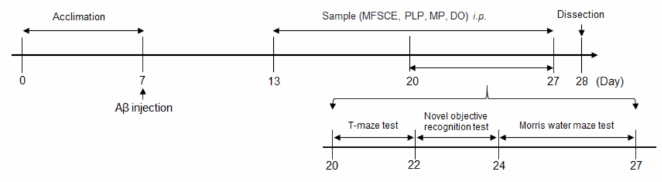
Figure 1. Experimental and behavioral procedure for